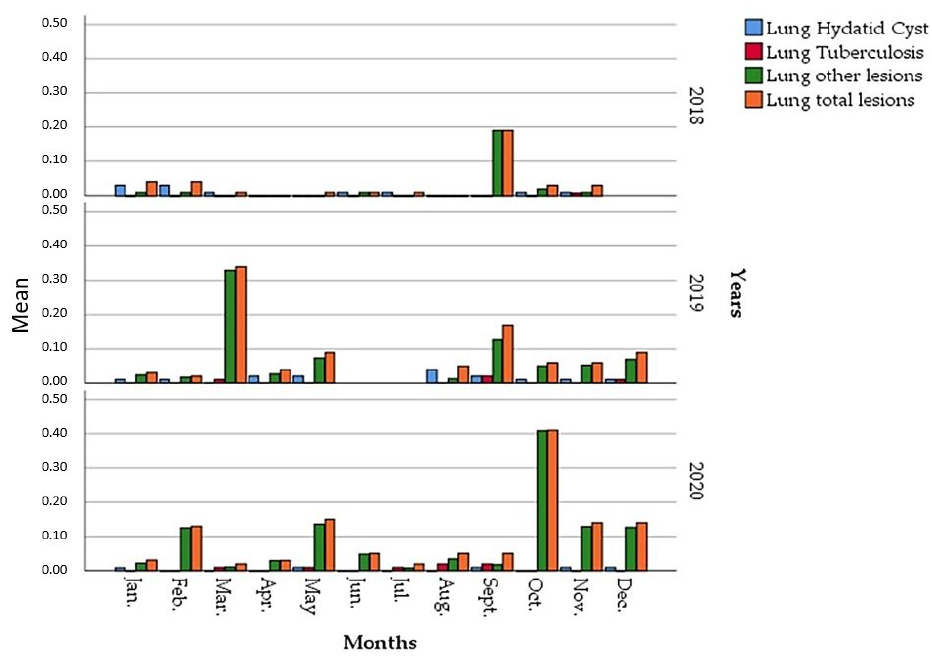
Figure 6. Monthly prevalences of the different lungs seizures reasons during 2018, 2019 and 2020.